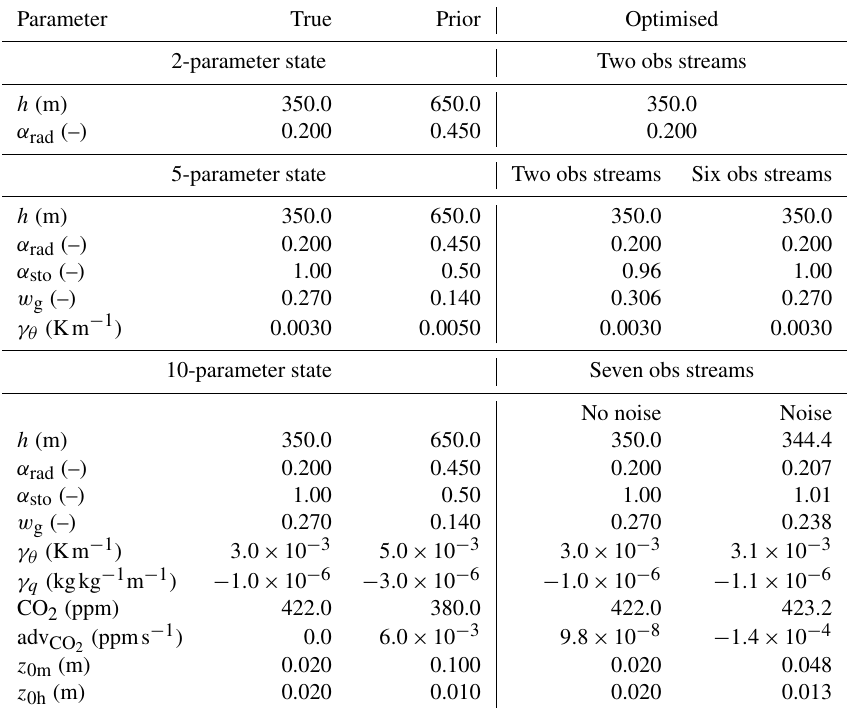
are added, and for the seven 2